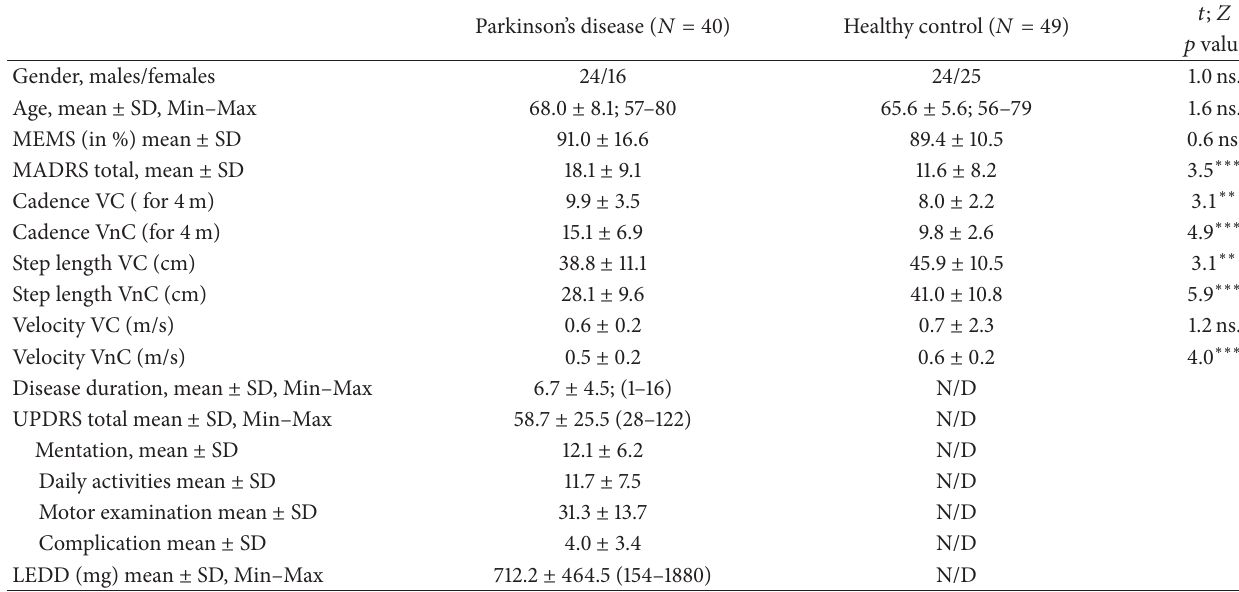
Table 1: Demographic and clinical characteristics of Parkinson’s disease patients and healthy control persons. MEMS = Mini-Exam of Mental Status; MADRS = Montgomery-˚Asberg Depression Rating Scale; VC = visually controlled condition; VnC = visually noncontrolled condition; UPDRS = Unified Parkinson’s Disease Rating Scale; LEDD = levodopa equivalent daily dose. Parkinson’s disease ( 𝑁 = 40